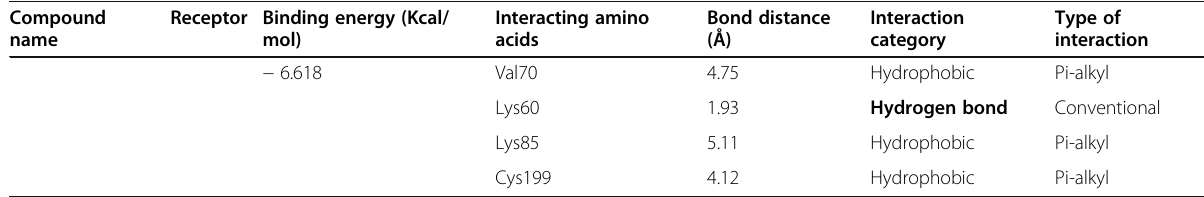
Table 1 Result of molecular docking between curcumin I (PubChem CID: 969516), curcumin II (PubChem CID: 5469424), curcumin III (PubChem CID: 5315472), and CK-1 (PDB Id: 2IZS) and GSK3B (PDB Id: 3F88) (Continued)